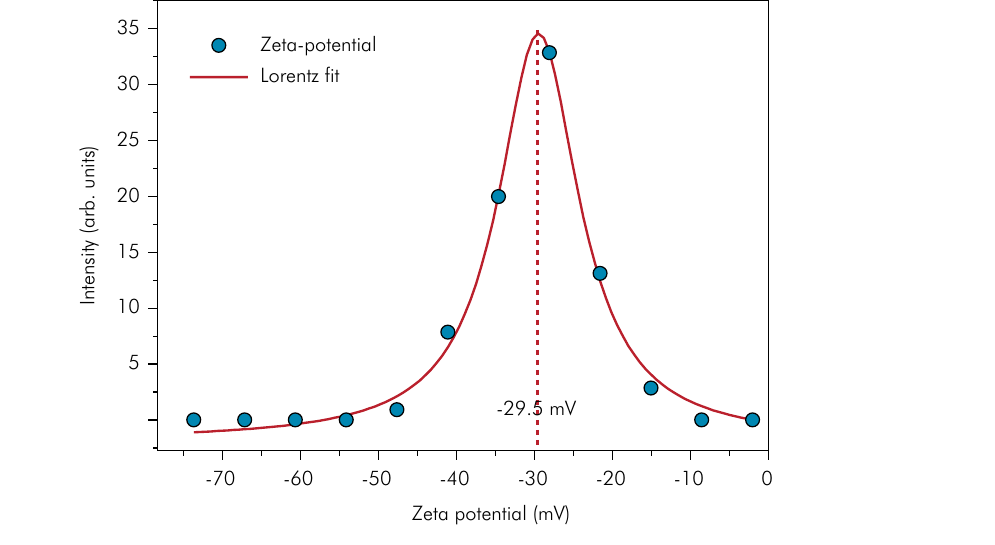
Figure 6. Zeta potential measurement of UC NP functionalized with PAA.